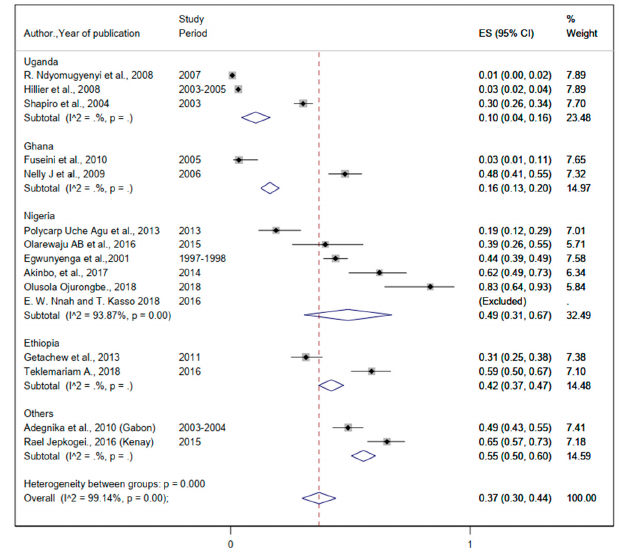
Figure 5. The proportion of Hookworm estimated from the overall helminthic infection among pregnant women in sub-Saharan Africa.